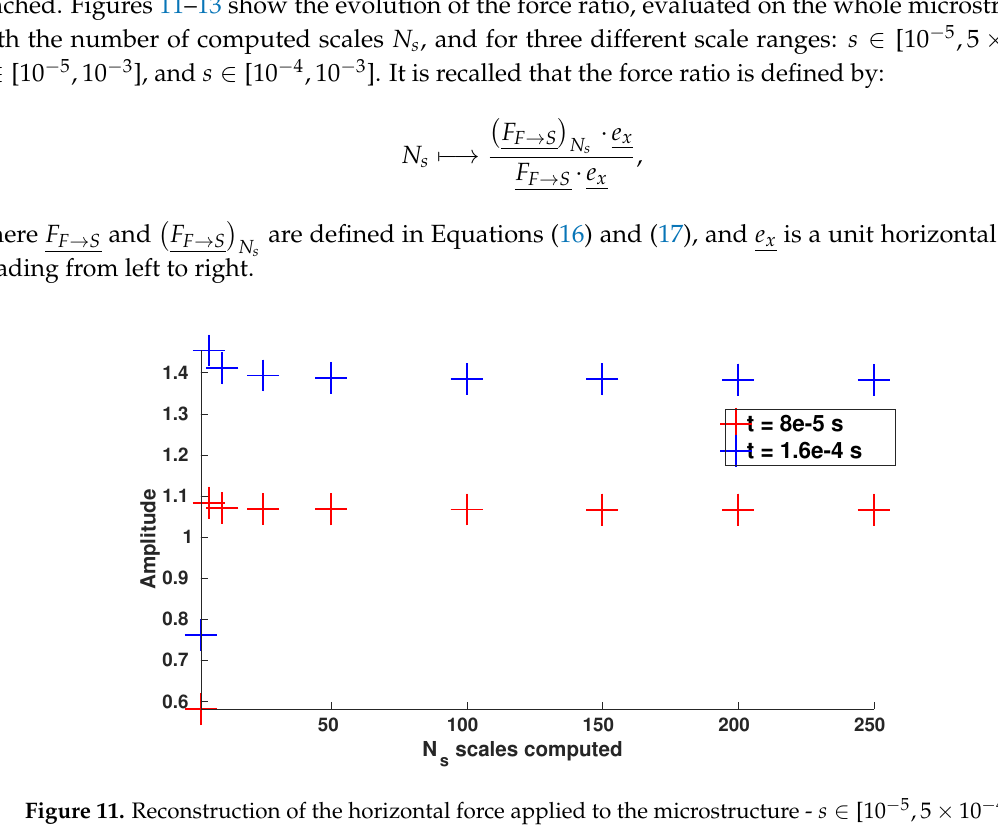
Figure 11. Reconstruction of the horizontal force applied to the microstructure - s ∈ [10 − 5 , 5 × 10 − 4 ].